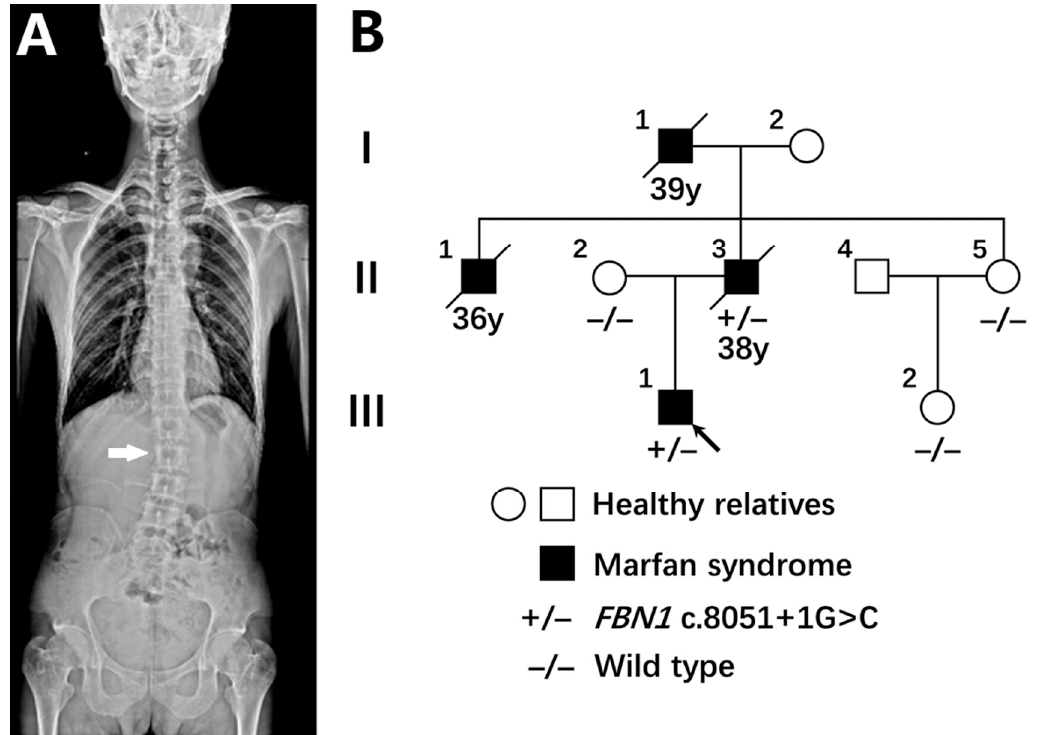
Figure 1. The clinical characteristics of the pedigree. ( A ) The anteroposterior X ‐ ray of the spine of the proband revealed lumbar scoliosis. ( B ) The family tree and genotypes of the MFS pedigree. Ar ‐ row indicates the proband. Males and females are indicated by squares and circles, respectively. Black filled symbols represent MFS clinically a ff ected individuals. +/ − , represents heterozygous FBN1 c.8051+1G>C mutation. − / − , represents wild type. Y, represents years old.